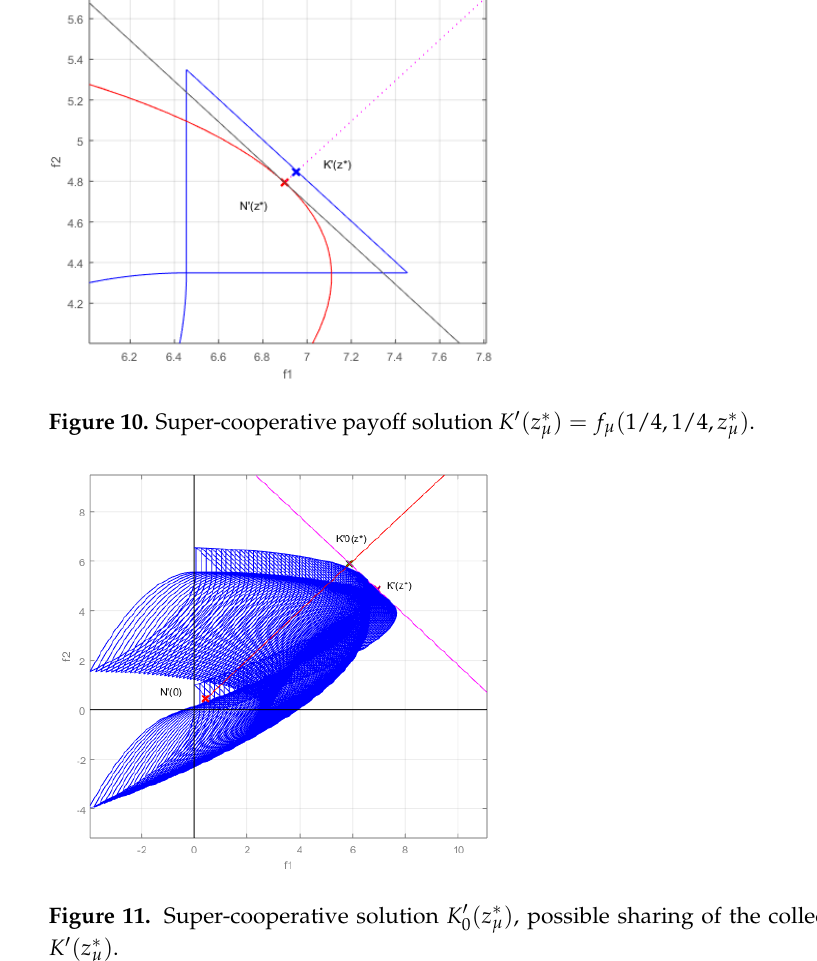
Figure 11. Super-cooperative solution K (cid:48) K (cid:48) ( z ∗ µ )